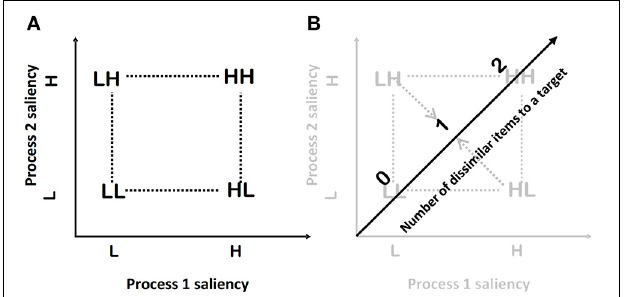
FIGURE 1 | (A) A schematic representation of the full-factorial design. (B) A schematic representation of the FFD, which is obtained by collapsing the full-factorial design to a one-dimensional design across the item position